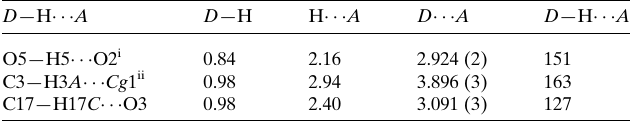
Table 1 Hydrogen-bond geometry (A˚ , (cid:3) ). Cg 1 is the centroid of the O2/C12–C16 furan ring.